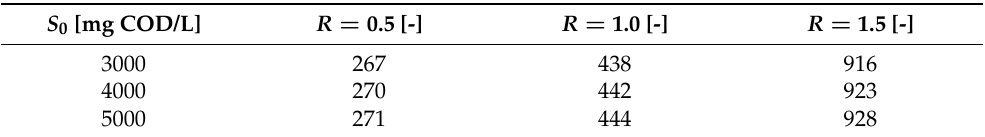
Table 2. Maximum values of F given different R and S 0 values. The same feed concentration S 0 = 4000 mg COD/L was used as in [16]. Another two values above and below this value were chosen. Regarding R , the same values were used as in [16].